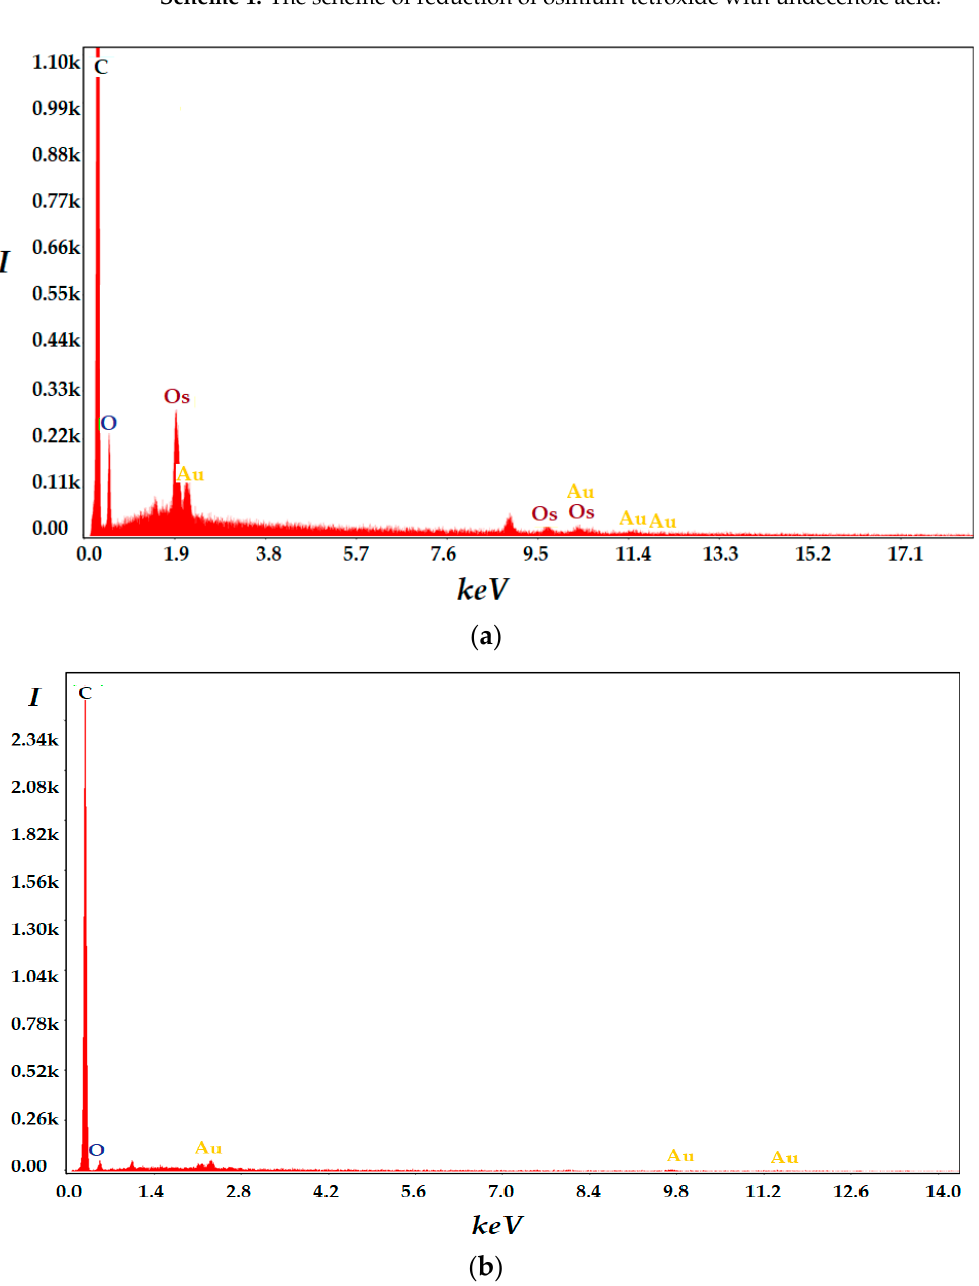
Figure 5. Formal aspect elemental analysis obtained by energy-dispersive spectroscopy analysis (EDAX) on: ( a ) composite membranes, and ( b ) polypropylene hollow fiber membranes support.